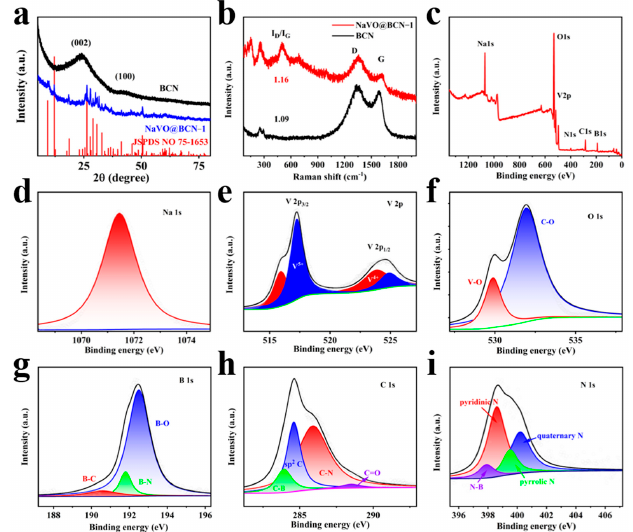
Figure 2. ( a ) XRD patterns of the NaVO@BCN-1 and BCN nanotubes; ( b ) Raman spectra of the NaVO@BCN-1 and BCN nanotubes; ( c ) XPS scan of the NaVO@BCN-1; ( d – i ) high-resolution XPS of